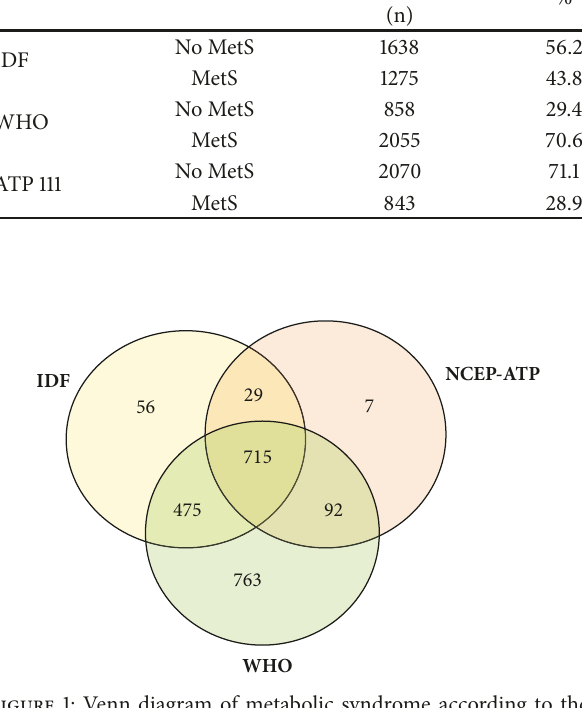
Figure 1: Venn diagram of metabolic syndrome according to the three different